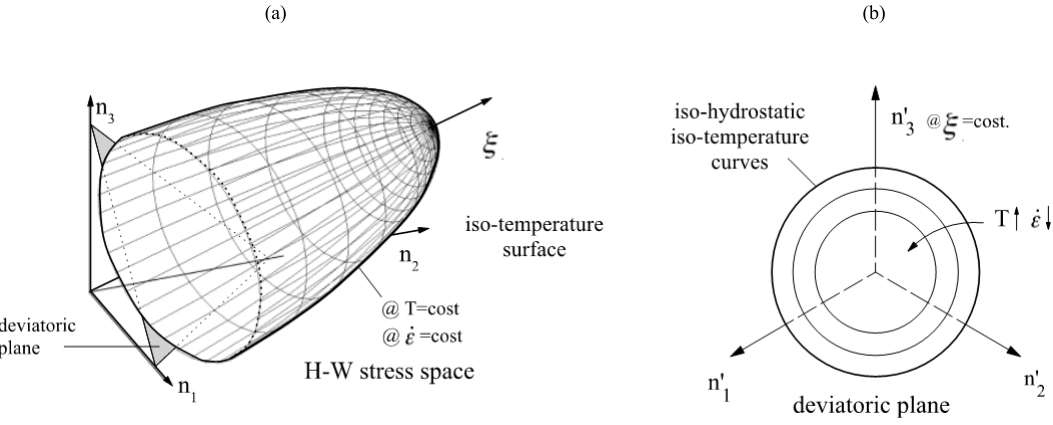
Fig. 3 (a) Proposed generalized triaxial model over the three-dimensional Haigh-Westergaard stress space (b) Iso-hydrostatic sections on the deviatoric plane at varying temperature and strain rate